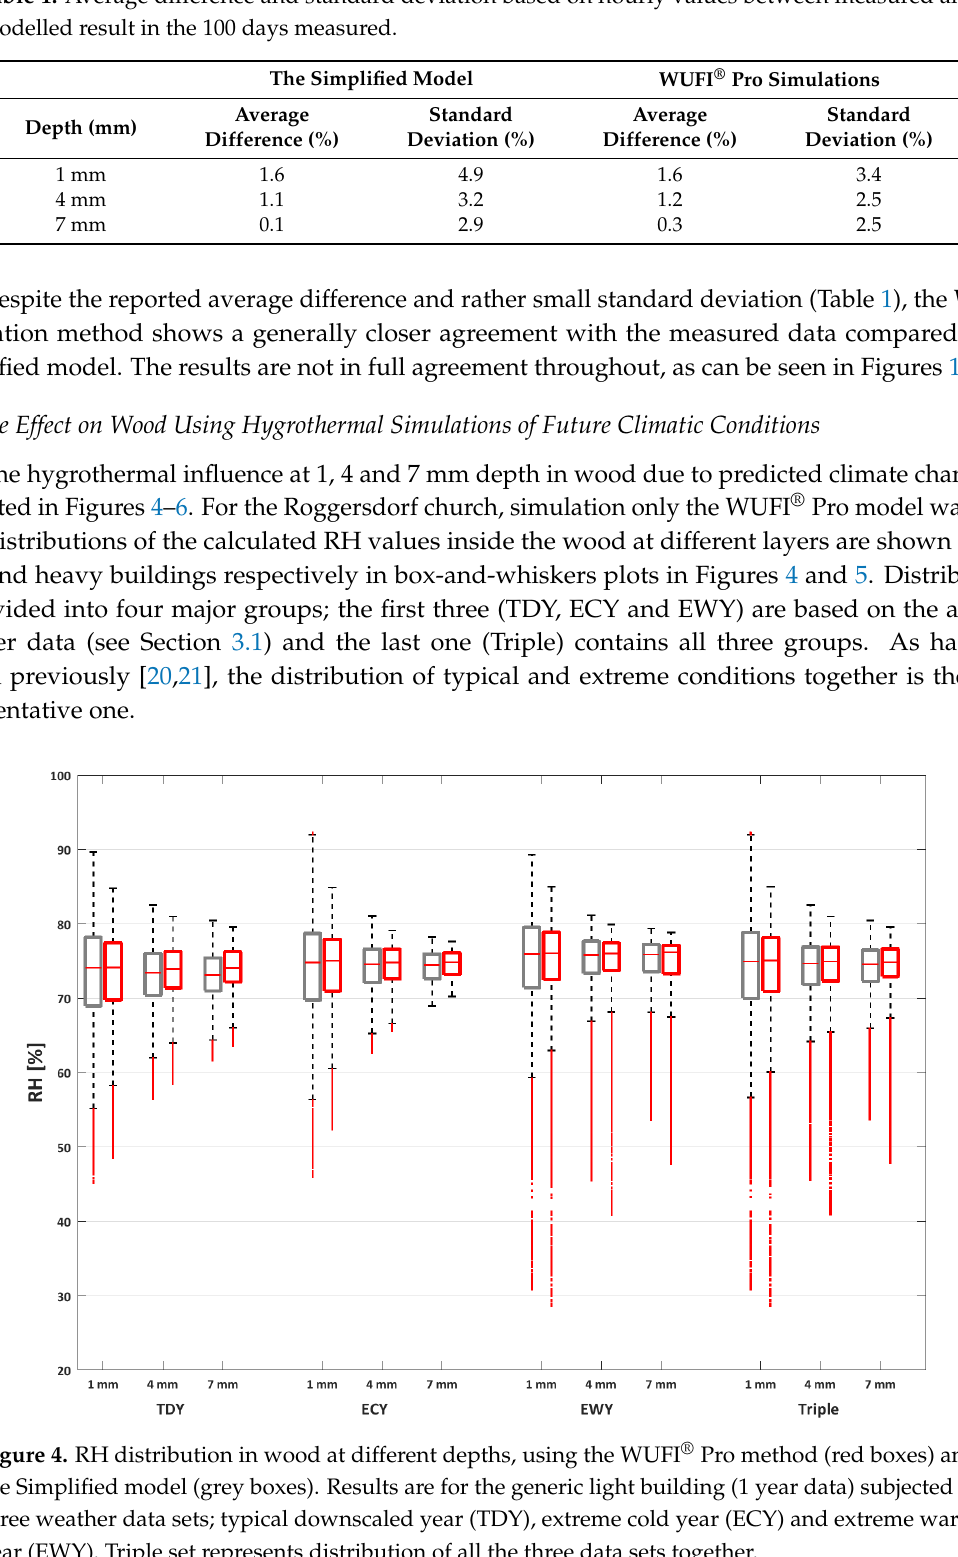
Figure 4. RH distribution in wood at different depths, using the WUFI ® Pro method (red boxes) and the Simplified model (grey boxes). Results are for the generic light building (1 year data) subjected to three weather data sets; typical downscaled year (TDY), extreme cold year (ECY) and extreme warm year (EWY). Triple set represents distribution of all the three data sets together.